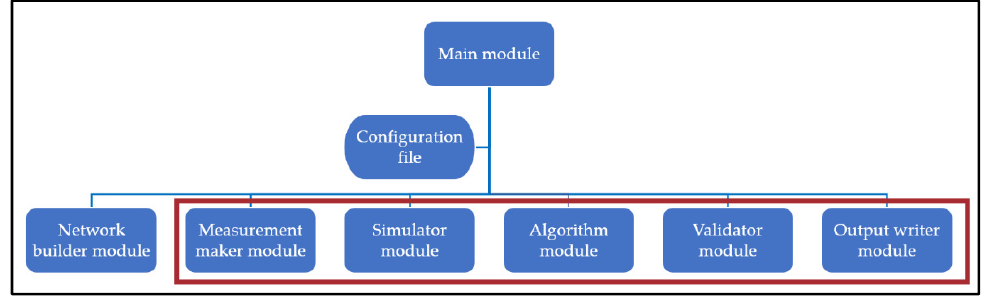
Figure 2 . Architecture of the DSSE tool . Modules inside the red box perform the run of DSSE, while those outside the red box perform data management and preprocessing.